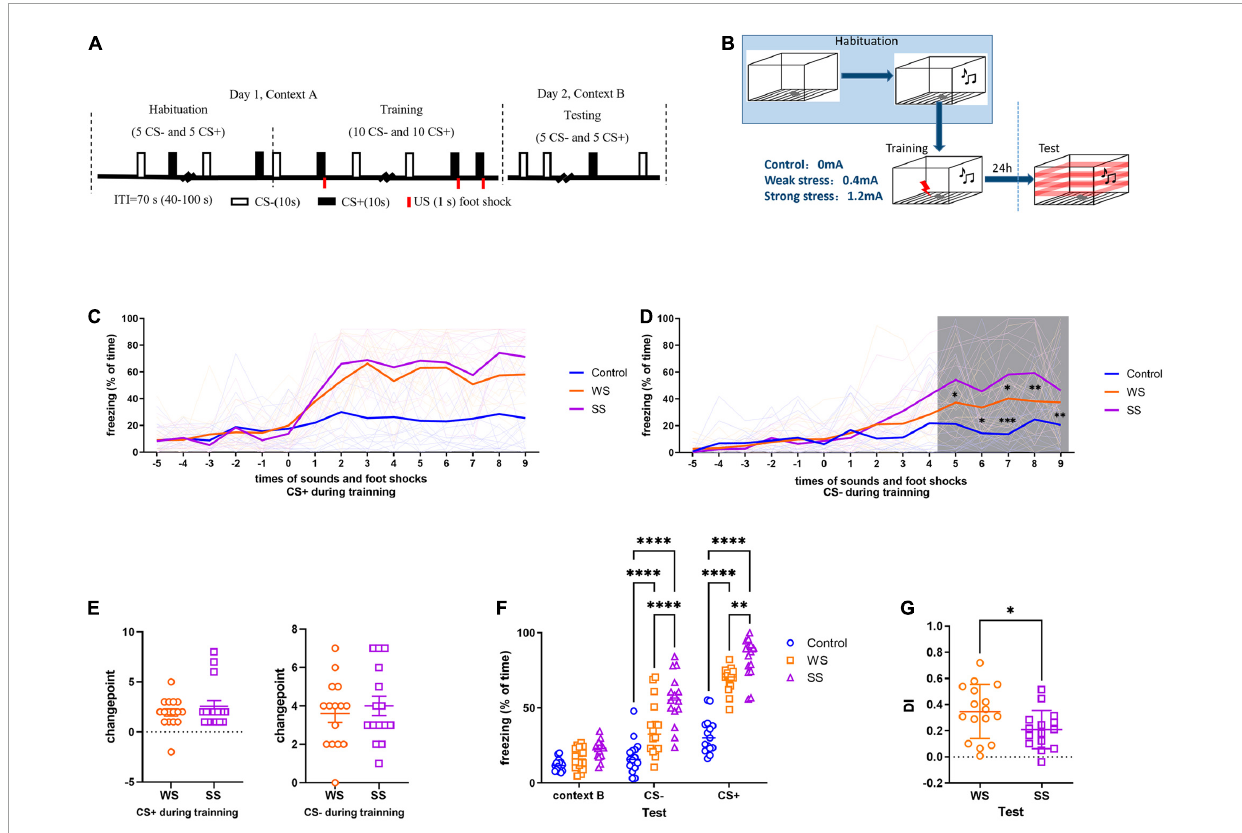
FIGURE1 Fear conditioning by foot shock of different intensities caused incremental generalization. (A,B) Fear conditioning paradigm (15 mice in each group). (C) On day 1, no significant difference was found in the freezing to CS+ between WS and SS groups (two-way ANOVA, F 2 , 43 = 33.45, p < 0.0001, Tukey’s multiple comparisons test). (D) Mice in SS group had higher freezing to CS- than that in WS group (two-way ANOVA, F 2 , 43 = 7.377, p = 0.0018, Tukey’s multiple comparisons test). ∗ p 5 [ Control vs SS ] = 0.0131, ∗ p 6 [ Control vs SS ] = 0.0125, ∗∗ p 7 [ Control vs WS ] = 0.0022,